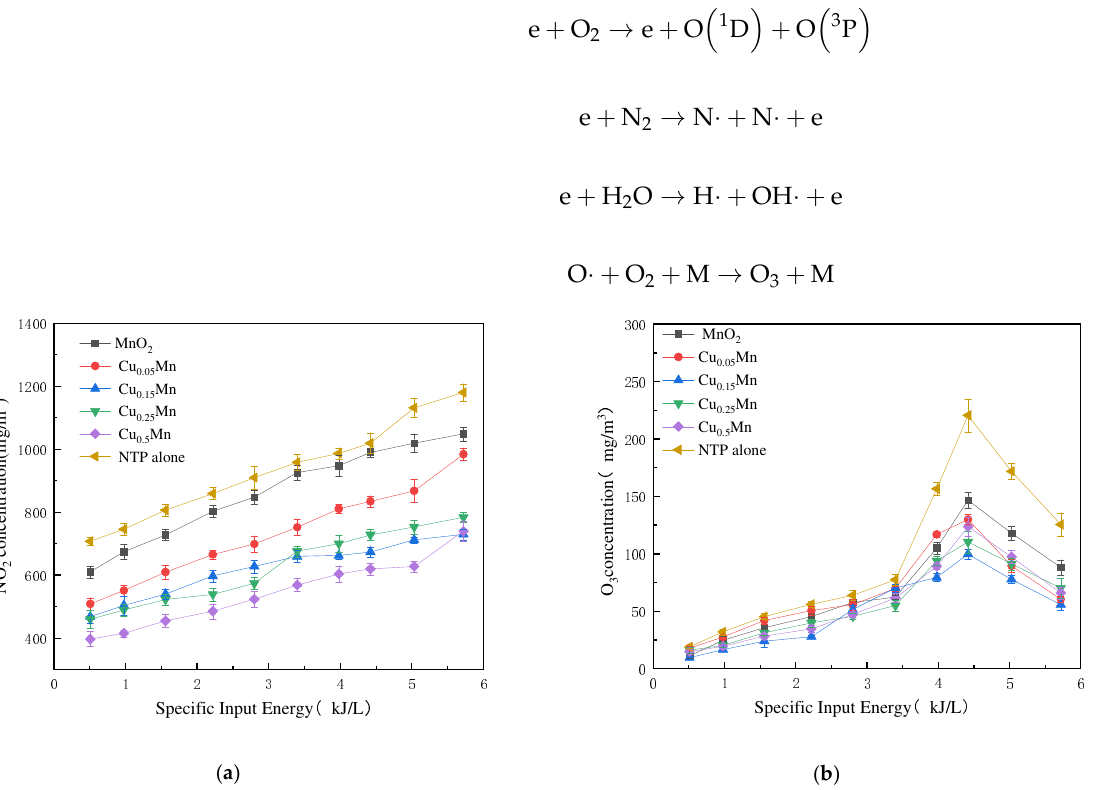
Figure 7. The relationship between by-product concentration and SIE with different catalysts. ( a ) NO 2 and ( b ) O 3 .